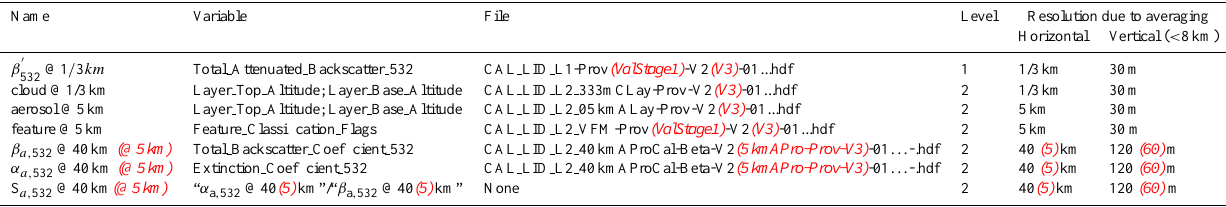
Table 1. CALIOP parameters used in this study with attributed name, variable, file, level and horizontal/vertical resolution-version 2 in black 0 and version 3 in red italic. The parameters β @1/3km, cloud @1/3km, aerosol @5km and feature @5km have the same horizontal and 532 vertical resolution in CALIOP version 2 and version